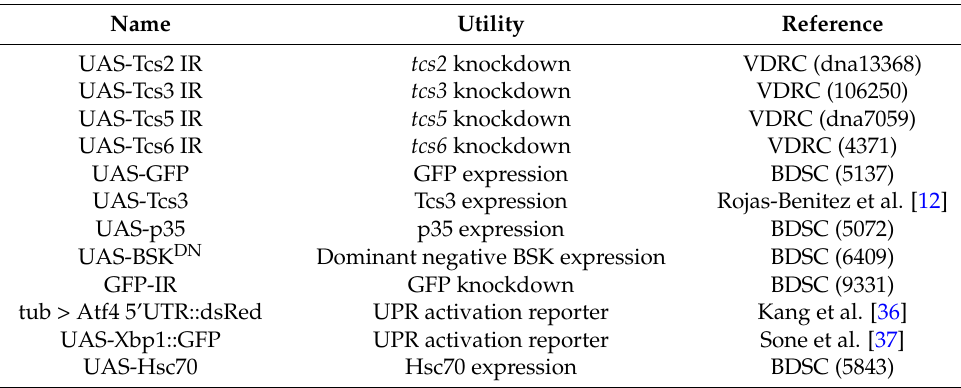
Table 2. List of upstream activating sequence (UAS) lines